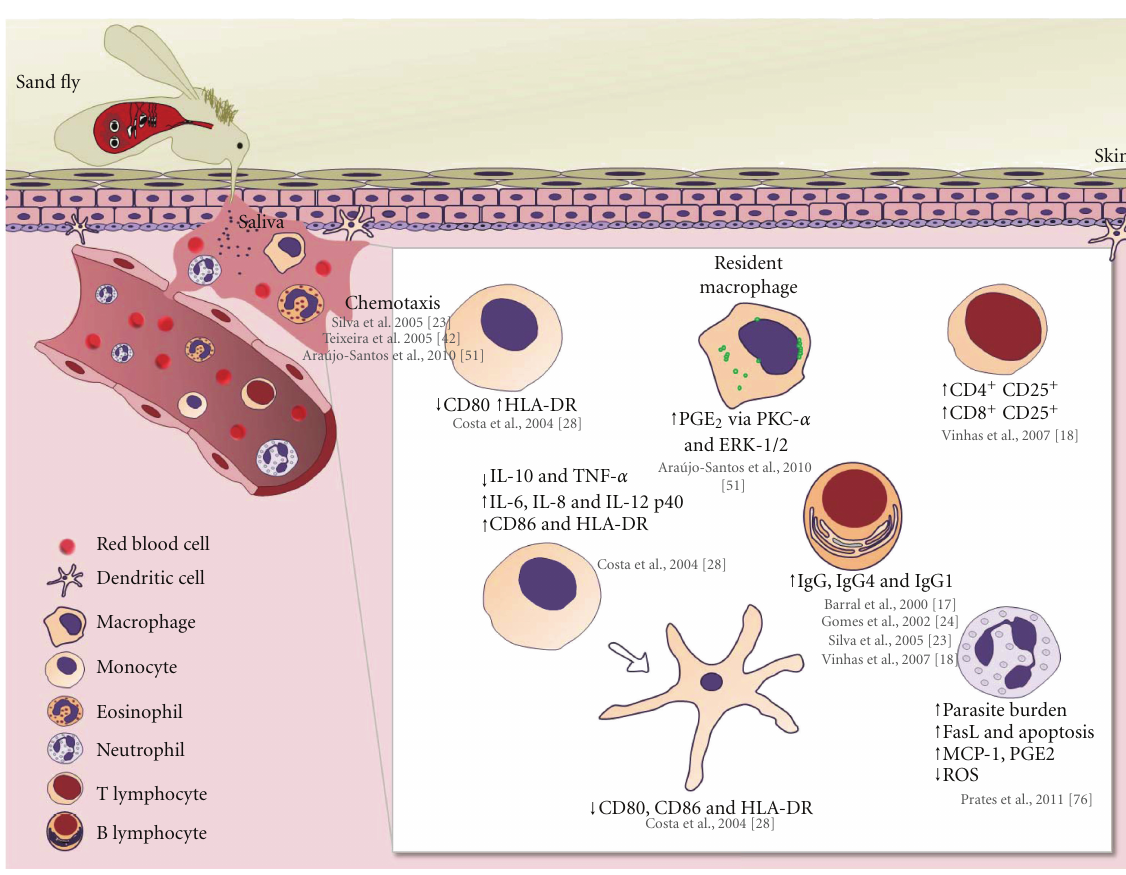
Figure 1: Roles of Lutzomyia longipalpis saliva in host immune response cell. After L. longipalpis saliva injection a set of events can be triggered in the host immune response. Herein, we summarized the roles of saliva on major cell populations involved in the host immune response against Leishmania